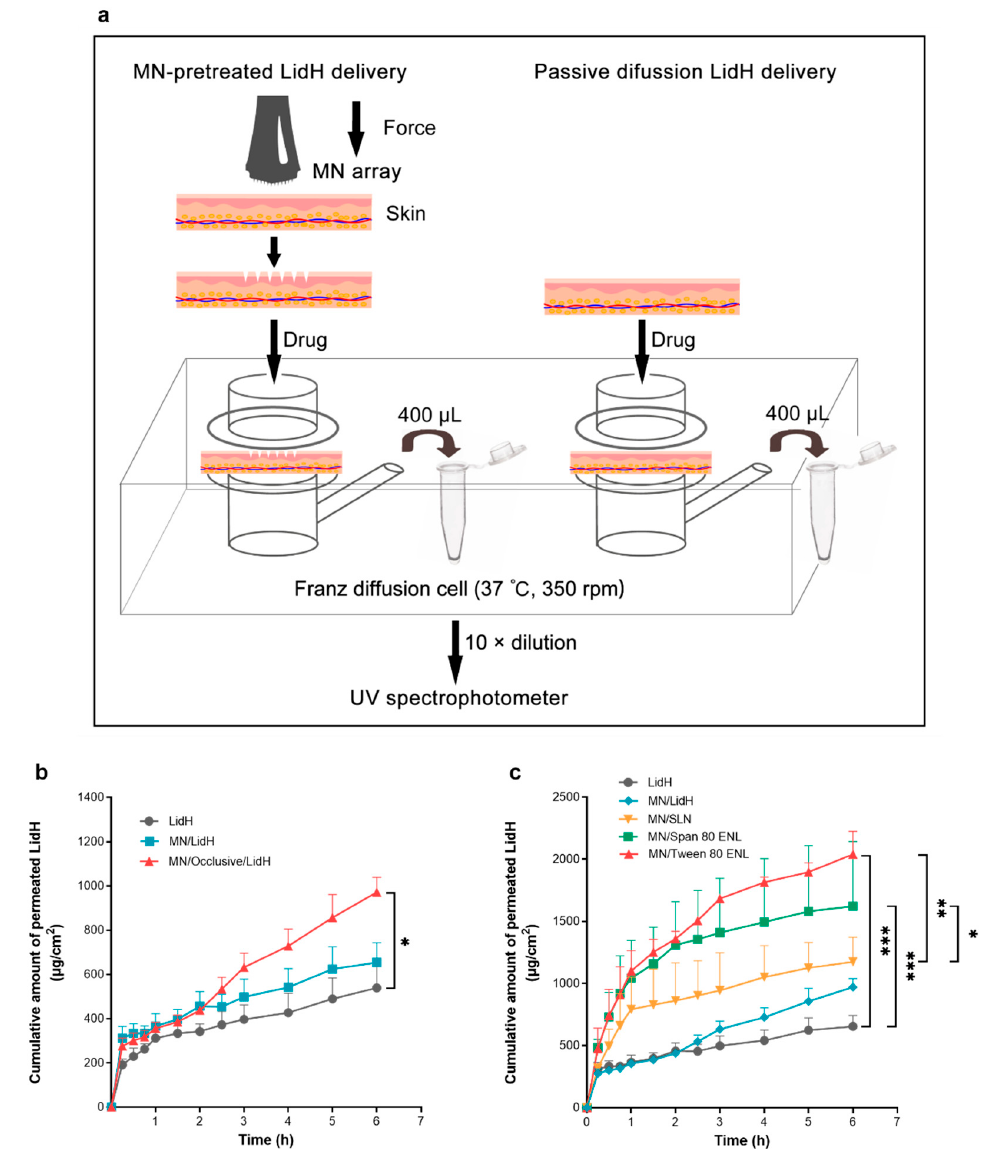
Figure 2. In vitro transdermal delivery of LidH ENL formulations. ( a ) In vitro diffusion studies of LidH ENLs on mouse skin using Franz diffusion cells. ( b ) Cumulative permeation of LidH in MN-pretreated skin after occlusive application. ( c ) Cumulative permeation of LidH in two types of ENL formulation was compared with that in SLN after occlusive application on MN-pretreated skin. Data are shown as mean ± SD, n = 3. *: p < 0.05, **: p < 0.01, ***: p < 0.001; Student’s t -test. Abbreviations: ENL, elastic nano-liposome; LidH, lidocaine hydrochloride; MN, microneedle; SLN, solid lipid nanoparticle.